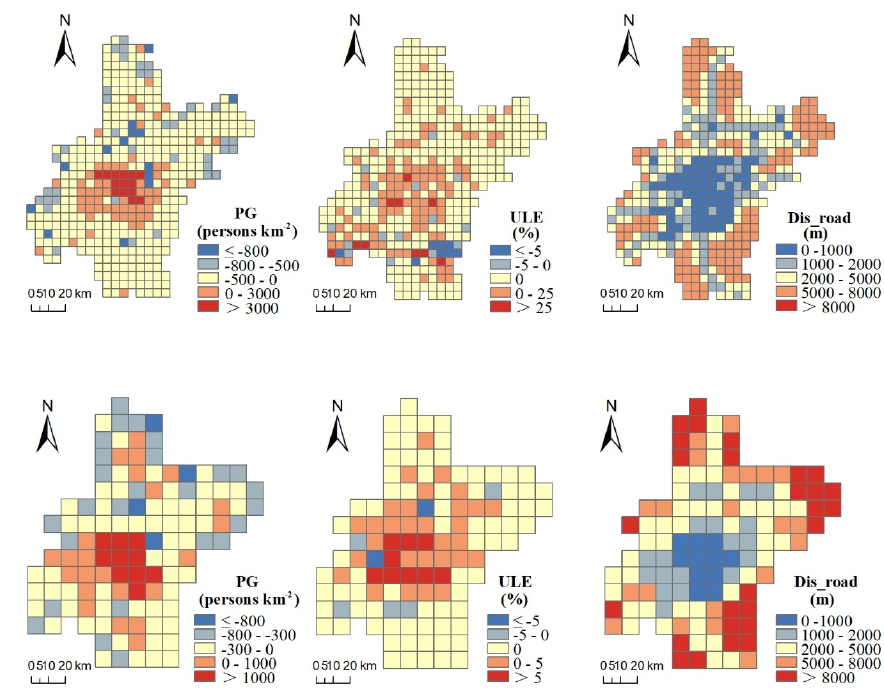
Figure 4. Spatial patterns of indicators for urbanization during 2005–2015 at 5 km ( upper row ) and 10 km ( lower row ) grid scales. Abbreviations: Population growth (PG); Urban land expansion (ULE); Distance to major roads (Dis_road).